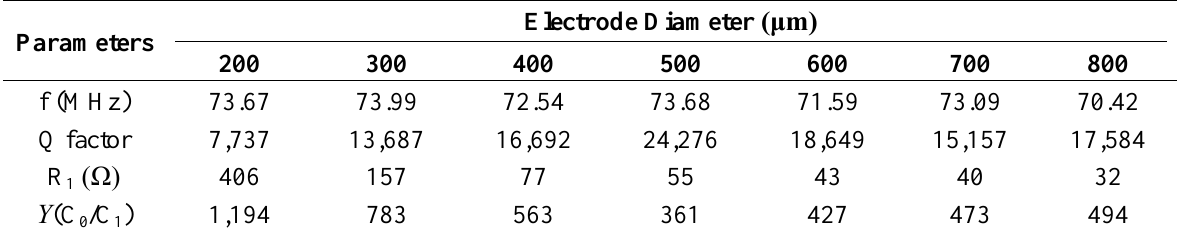
Table 1. Measured characteristics of 73 MHz